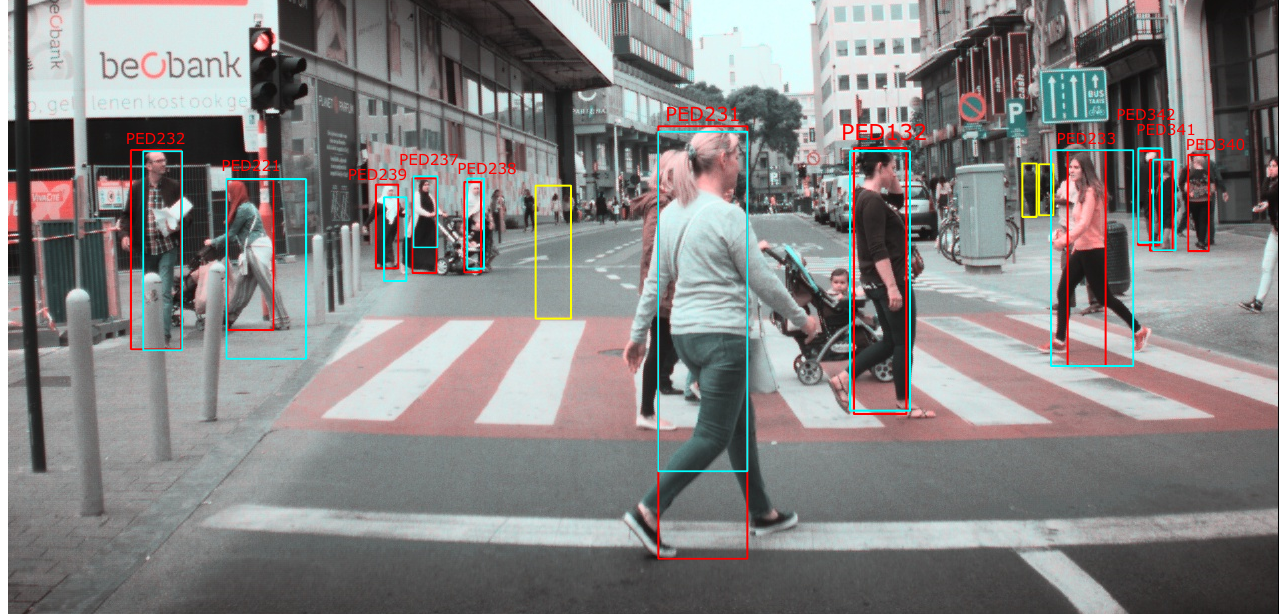
Figure 8. Results of Pedestrian Detection. Red rectangles represent ground truth for objects with a given ID. Blue rectangles represent the detection algorithm output that has equivalents in GT. Yellow rectangles are false positives results. In the pedestrian case, where boxes are typically strongly oblong, deviations on the base should be significantly influential. However, the Jaccard Index puts more importance on missed pixels in horizontal direction than in vertical. The distance measure (and the general measure too) behaves in the reverse sense. See Table